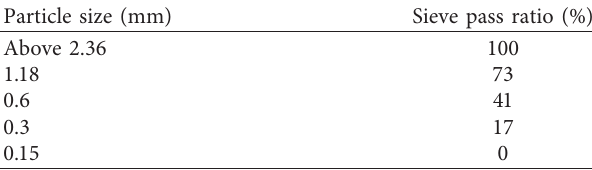
Table 4: Clogging mixtures.